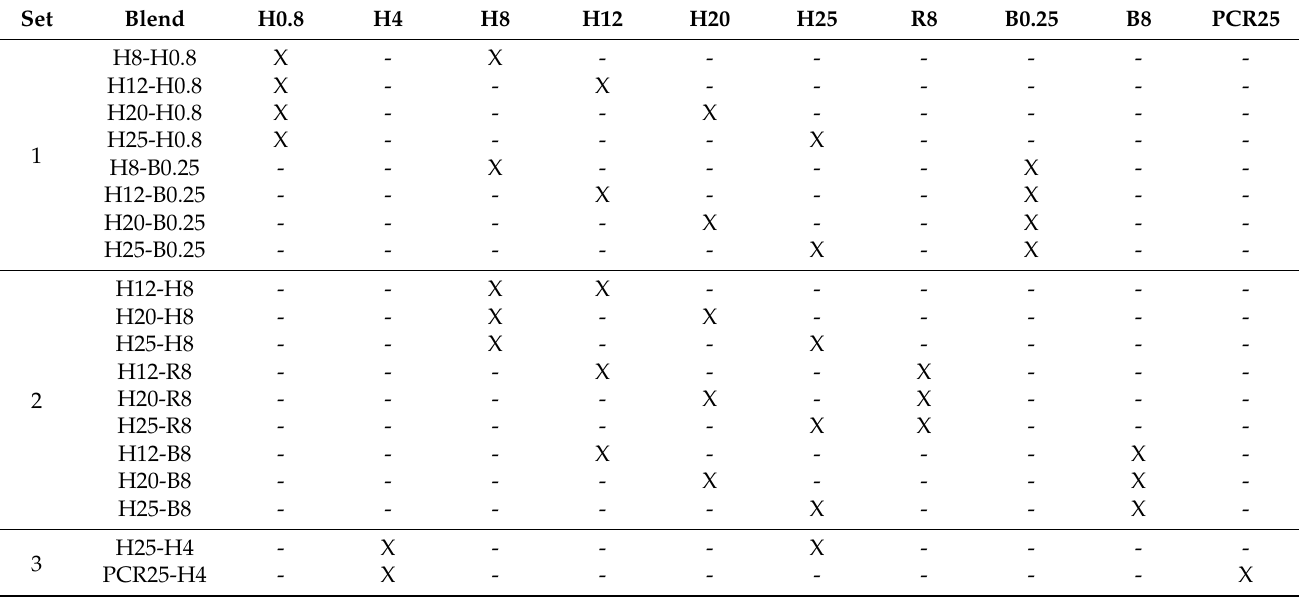
Table 3. Description of sample sets and blending partner composition.